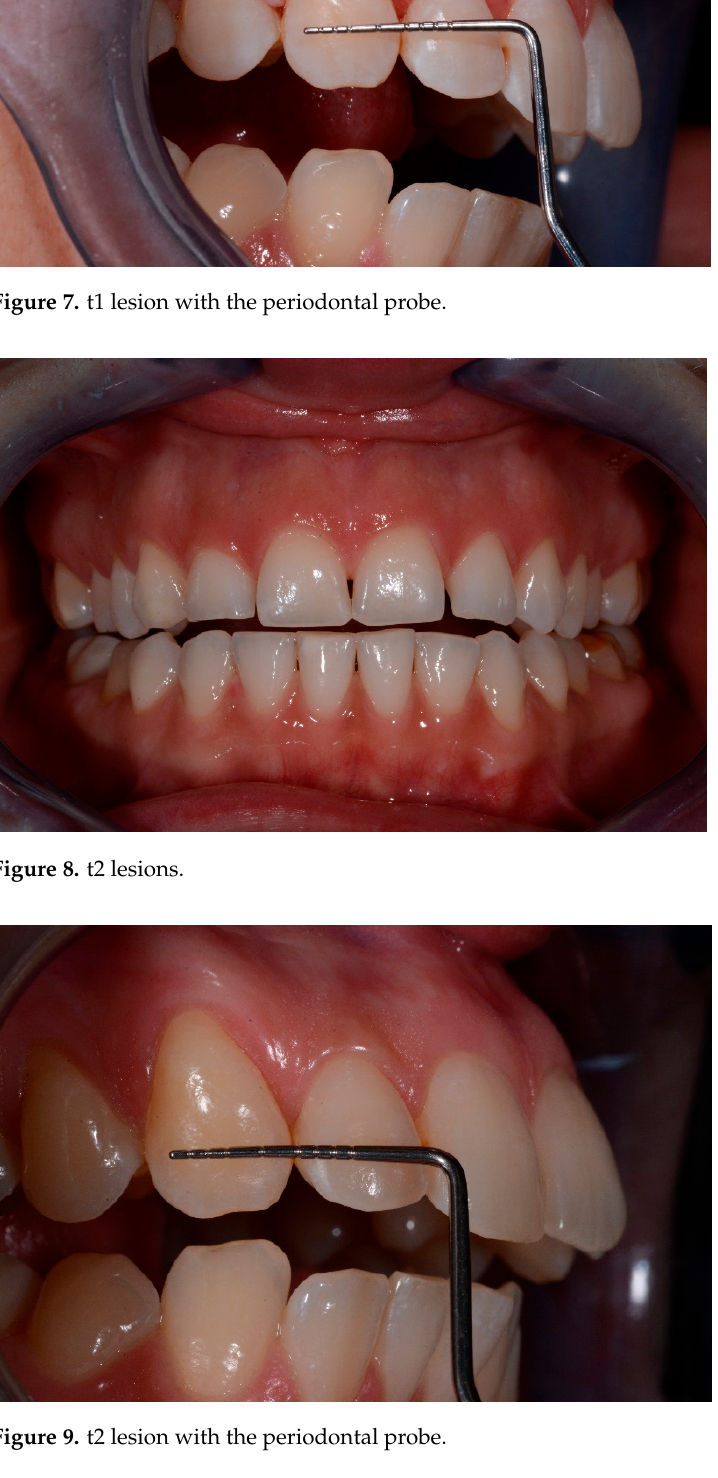
Figure 5. Baseline lesion with the periodontal probe . Figure 9. t2 lesion with the periodontal probe . Figure 9. t2 lesion with the periodontal